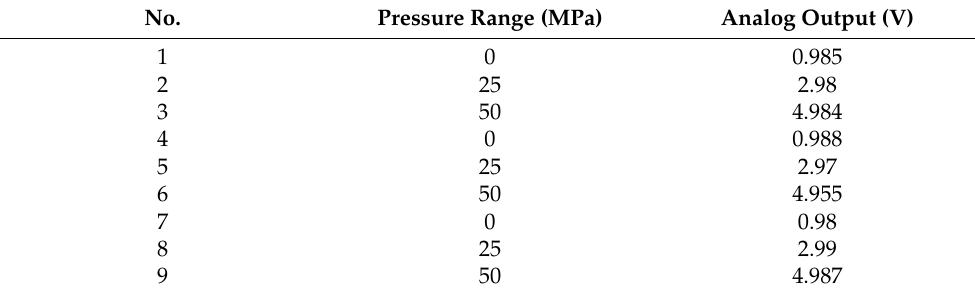
Table 1. Results of the Explosion Pressure sensor calibration.